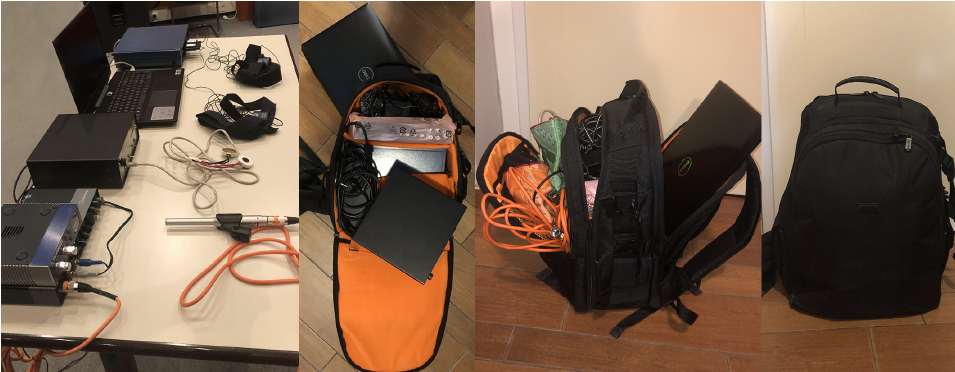
Figure 1. The entire experiment setup equipment, both ready-for-use ( left ) and fitting a backpack ( center and right